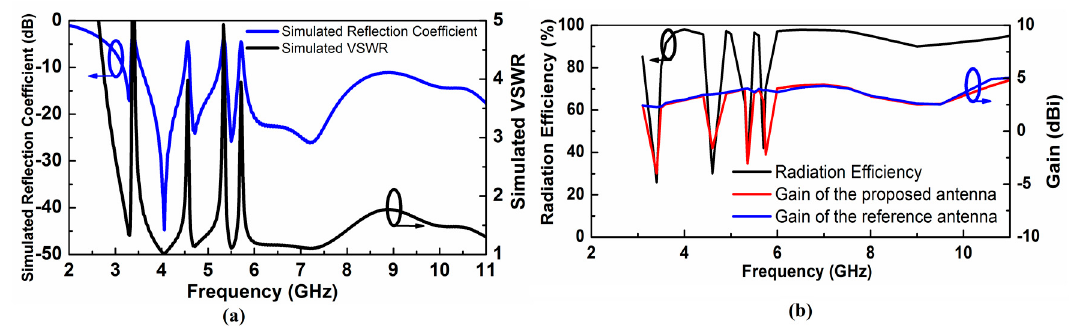
Figure 2. ( a ) Simulated Voltage Standing Wave Ratio (VSWR) and antenna reflection coefficient ( b ) Radiation efficiency and antenna gain versus frequency.